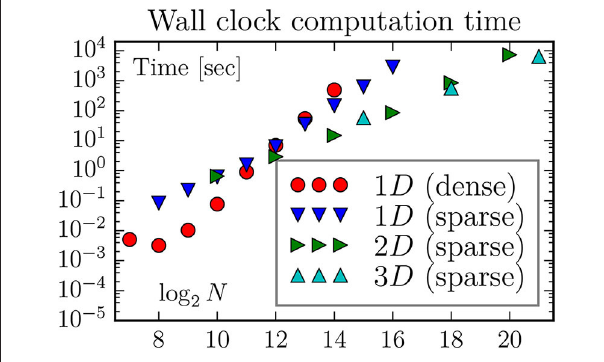
FIGURE 4 | The wall clock time used to find the lowest 128 eigenvalues, for various systems and methods. We have also used the dense matrix routine eigvalsh to compute the eigenvalues of a 2 7 two-dimensional lattice; not unexpected it takes the same time as for a 2 14 one-dimensional lattice. Somewhat surprisingly, with eigsh it is much faster to find the eigenvalues for two-dimensional lattice than for a one-dimensional with the same number of sites, and somewhat faster to find the eigenvalues for a three-dimensional lattice than for the two-dimensional with the same number of xe / 2. For the other = − 2 7 to =